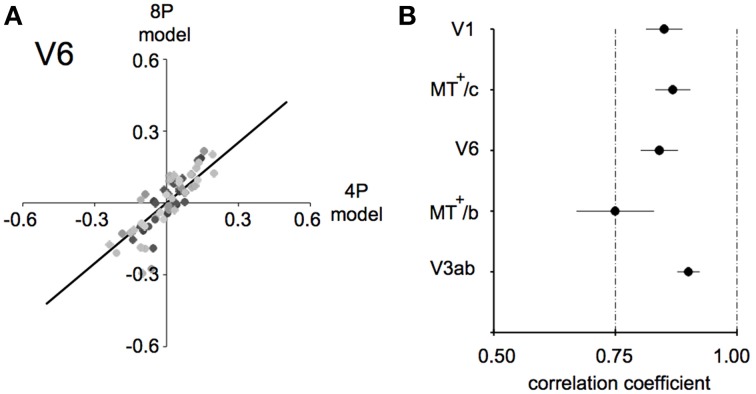
Model fit comparison between the 4P-model and the 8P-model (A) illustration of the model fit for V6. We started out by subtracting those components of the BOLD signal that explained the common response to the flow and low frequency drifts that was common to all conditions. Then, we computed the condition specific BOLD modulation explained by the binocular signals (4P-model) or by a hemodynamic function fit to each condition separately (8P-model). Thus, we arrive at two model fits for each condition/subject/ROI combination (black dots). The bold black line indicates the optimal linear fit of these points (least squares). (B) Average correlation values for each ROI between the 4P- and 8P-model. If the 4P-model would capture all of the BOLD modulations between conditions, its correlation with the 8P-model would reach 1.0, because the 8P-model serves as a reference of optimal fit of these modulations. Clearly the 8P-model achieves only a marginally better fit (±15%) in most ROIs and subjects.